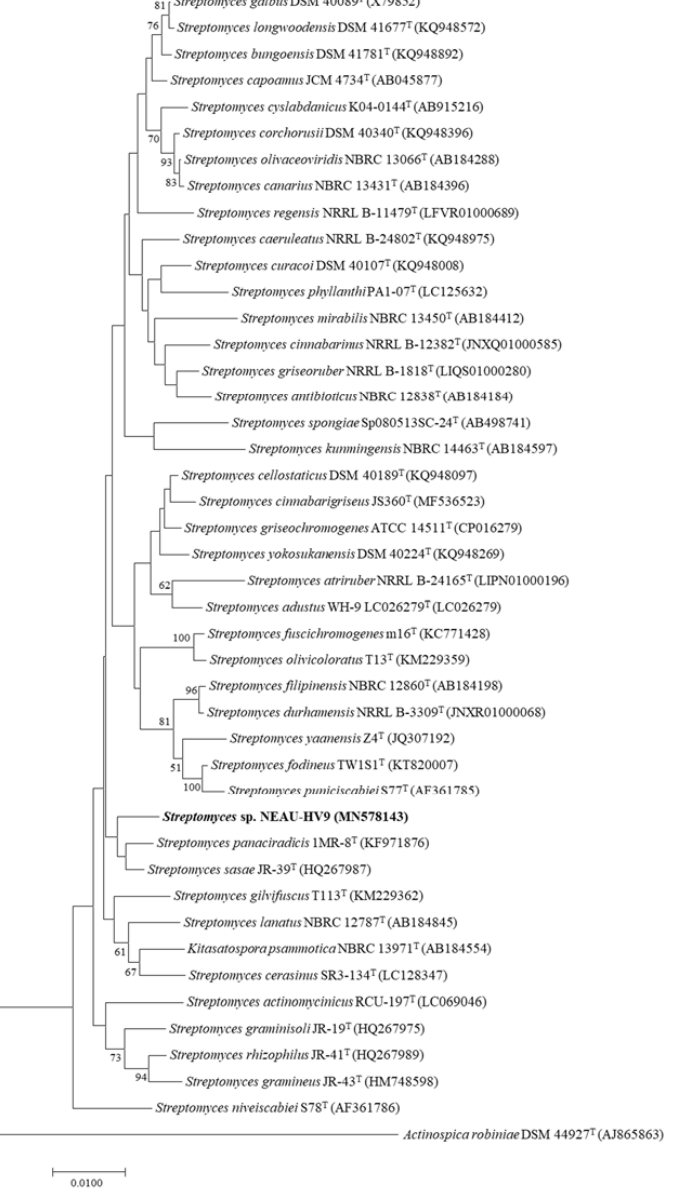
Figure 2. Neighbor ‐ joining phylogenetic tree based on 16S rRNA gene sequences showing the relationships among strain NEAU ‐ HV9 (bold) and members of the genus Streptomyces . Bootstrap percentages ( ≥ 50%) based on 1000 resamplings are listed at the nodes. Actinospica robiniae DSM 44927 T was used as the out ‐ group. Scale bar represents 0.01 nucleotide substitutions per site.